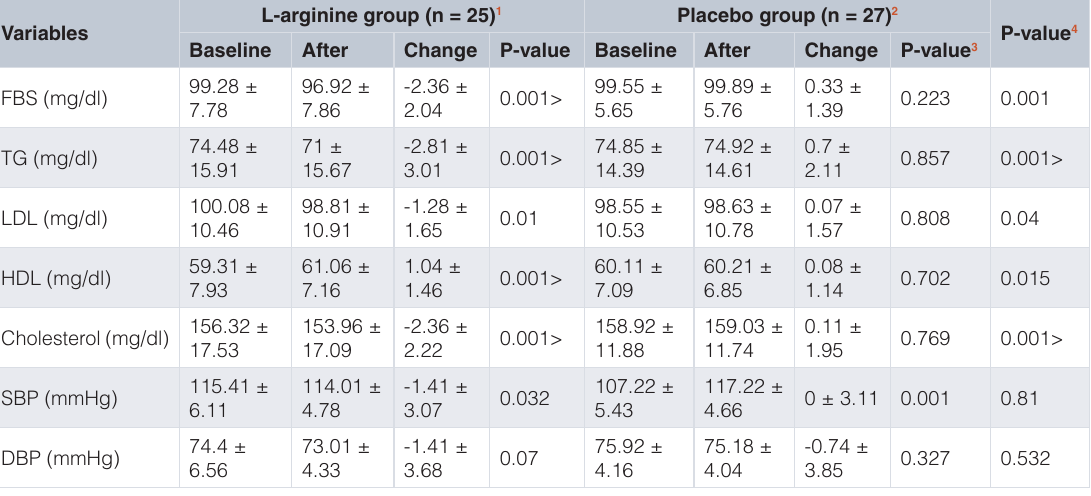
Table 3. Fasting blood sugar, lipid profile, systolic and diastolic blood pressure in L-arginine and placebo groups.